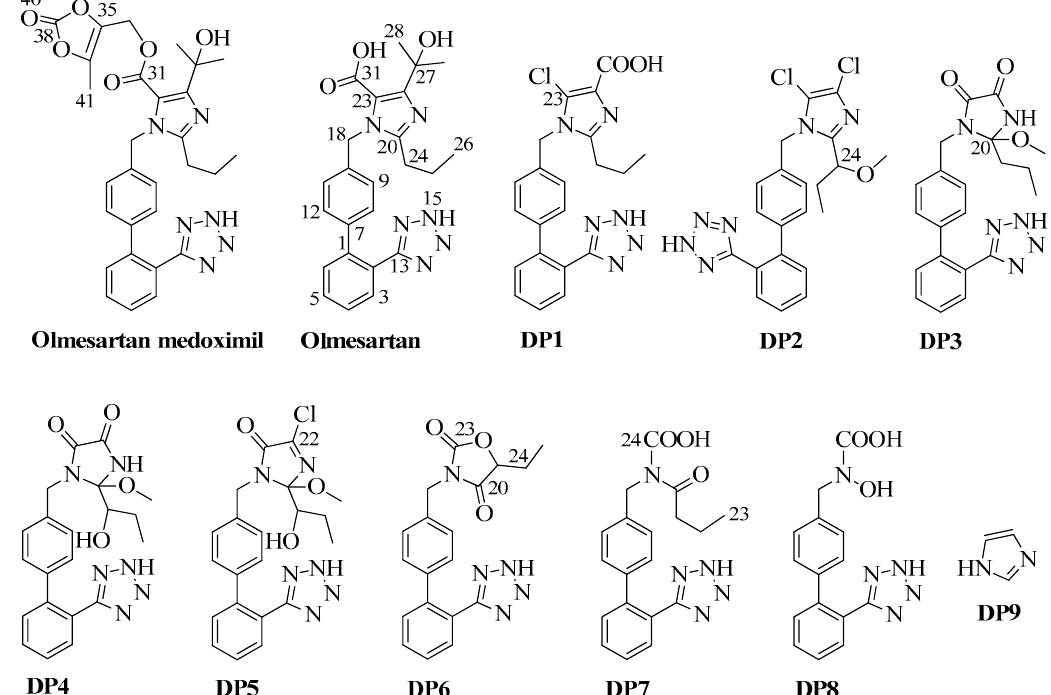
Figure 1. Olmesartan acid and the already known breakdown products.